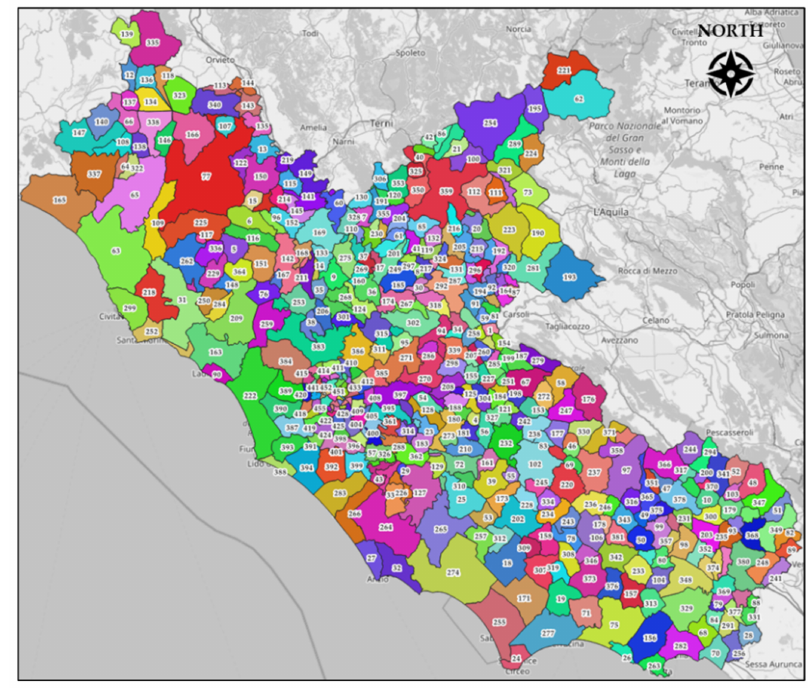
Figure 6. Lazio region: study area and